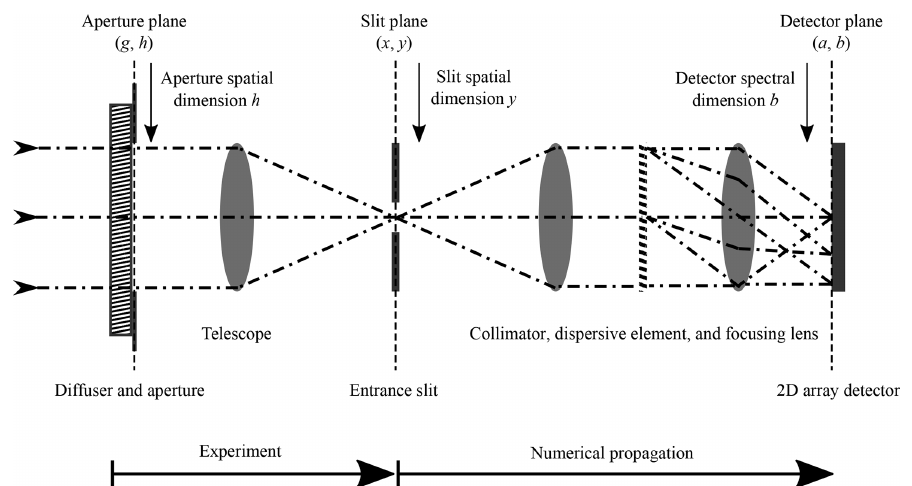
Figure 1. Optical setup of an imaging spectrometer during solar calibration. The sequence of optical components is subdivided into two parts. The first part is covered by the experimental setup in the lab, starting at the illuminated diffuser and ending at the slit in the telescope focal plane. The second part numerically propagates the images recorded in the slit plane to the instrument focal plane.